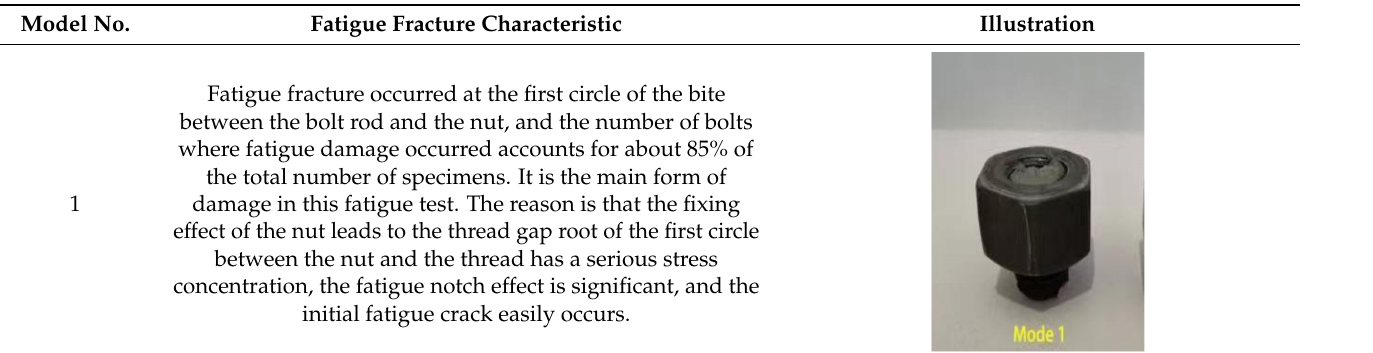
Figure 7. Fatigue failure of specimens. Table 4. Fatigue failure mode for high-strength